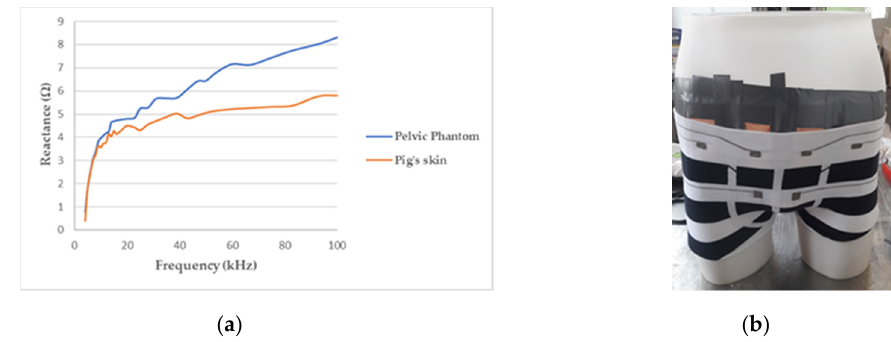
Figure 4. ( a ) Reactance of the pelvic phantom compared to the pig skin; ( b ) manikin wearing a boxer underwear incorporating flexible electrodes for bioimpedance measurement.